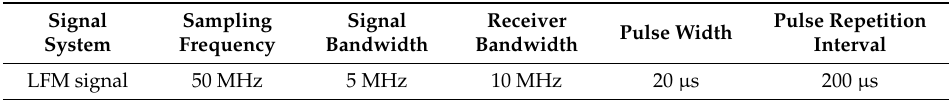
Table 1. Simulation parameters for the radar signal.